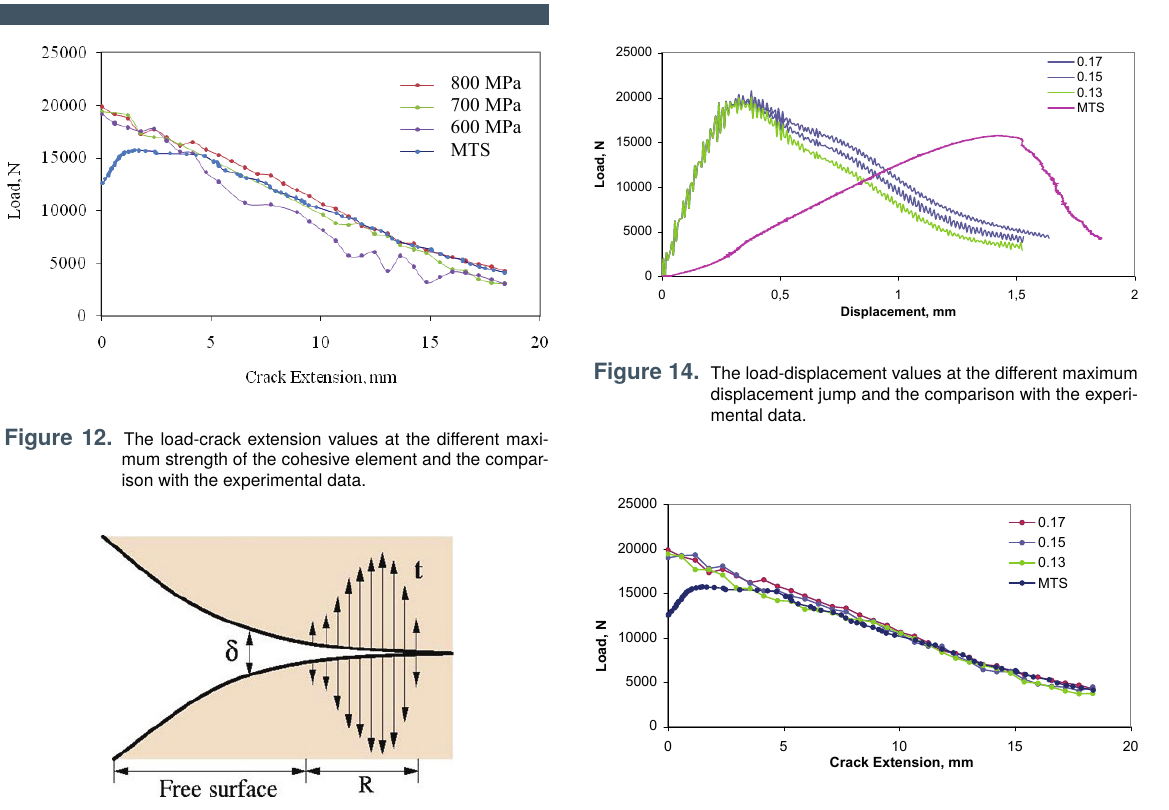
Figure 15. The load-crack extension response at the different max- imum displacement jump and the comparison with the experimental Figure 13: The visualization of the process zone at the crack tip, and definition of the displacement jump δ [6] . To analyze the material response due to the displacement jump three different sets (0.10, 0.12, and 0.14) of data were used. Figures 14 and 15 show the load-displacement and the load-crack extension response of Arcan specimen in mode-I in the different maximum displacement jump respectively. In that case, the maximum strength (Tmax) was considered as 800 MPa, the loading case the loading velocity was 0 . 6 × 10 − 03 mm/sec. Thus velocity 0.6x10 +02 mm/sec and mass density as 2.80x10 -05 ton/mm 3 . The crack length of 19.56 mm was observed. The obtained result shows that, up to the crack initiation, the load-displacement values were identical for the each case and no effect on the material response was observed. The material response was more or less the same up to 4.14 mm crack extension and after the higher load and displacement was required for the crack extension in higher δ value. The maximum displacement jump had more or less same effect as the maximum strength on the result. However Tmax, required higher load and displacement.